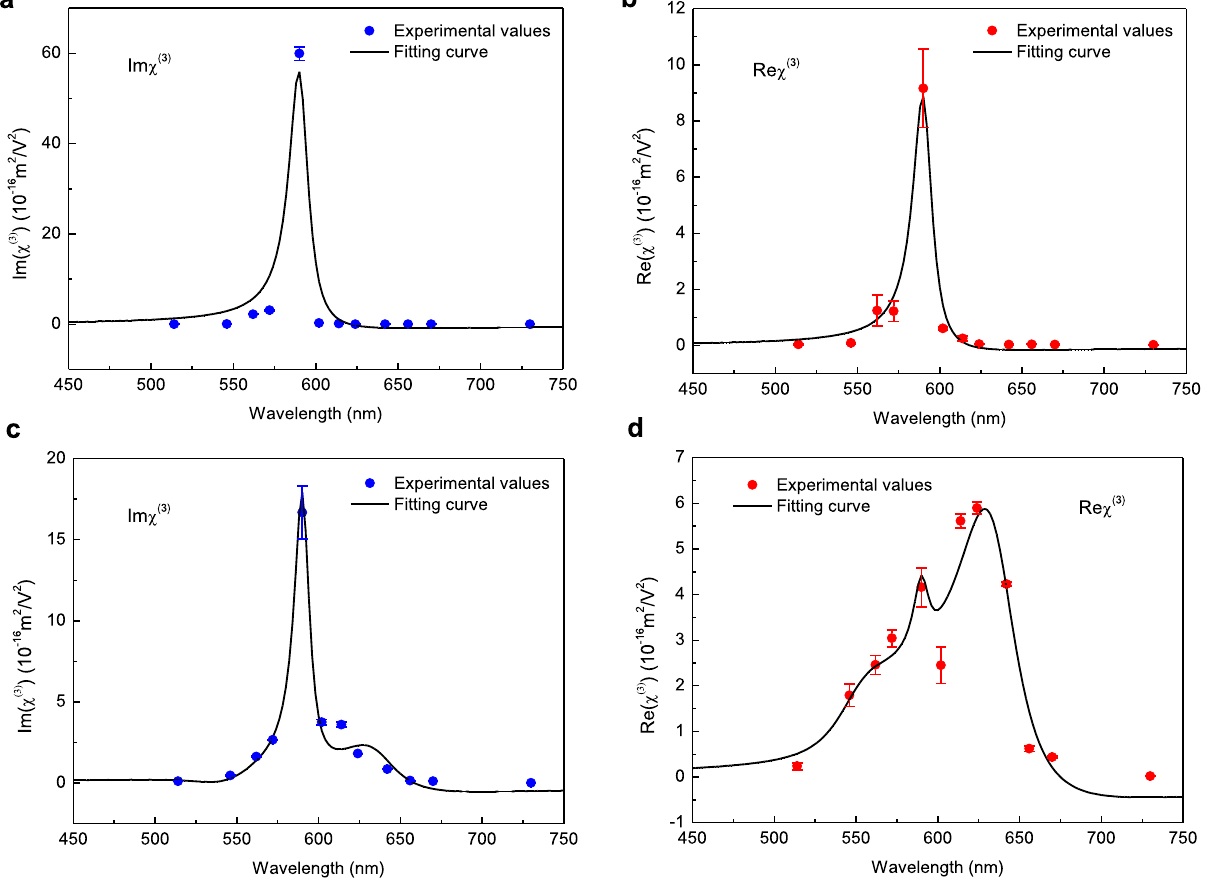
Fig. 7 Experimental and fi tted nonlinear susceptibilities of the coupled and uncoupled systems. Experimental and fi tted (black curves) absolute values of the third-order susceptibility of the uncoupled ( a , b ) and strongly coupled ( c , d ) systems. The blue circles in ( a , c ) and red circles in ( b , d ) represent the imaginary and real parts of the nonlinear susceptibility. The black curves are obtained with the nonlinear Lorentz model given by Eq. (3), and the error bars of each point are calculated from at least three sets of repeated